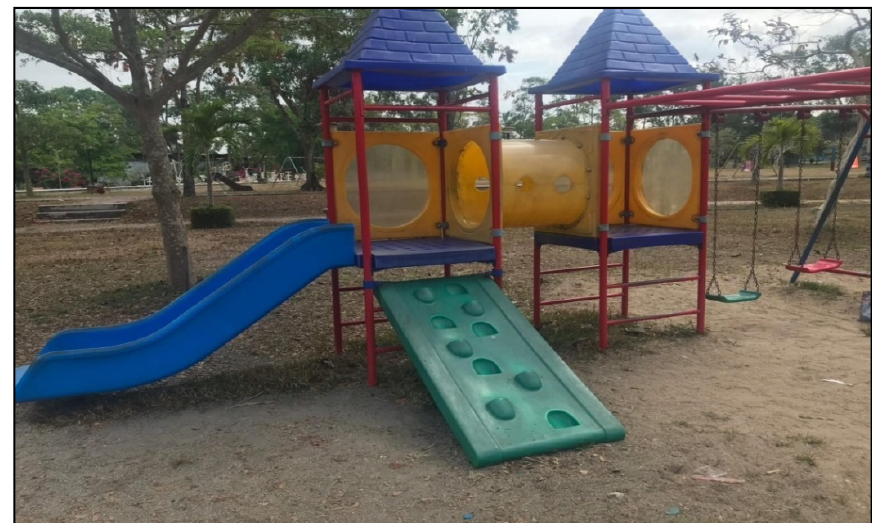
Figure 1. Mixed playground equipment set in the unsafe playground: arranged near other play- ground equipment; path for running had obstacles blocking the flow of traffic; damaged play- ground equipment; broken plastic parts.